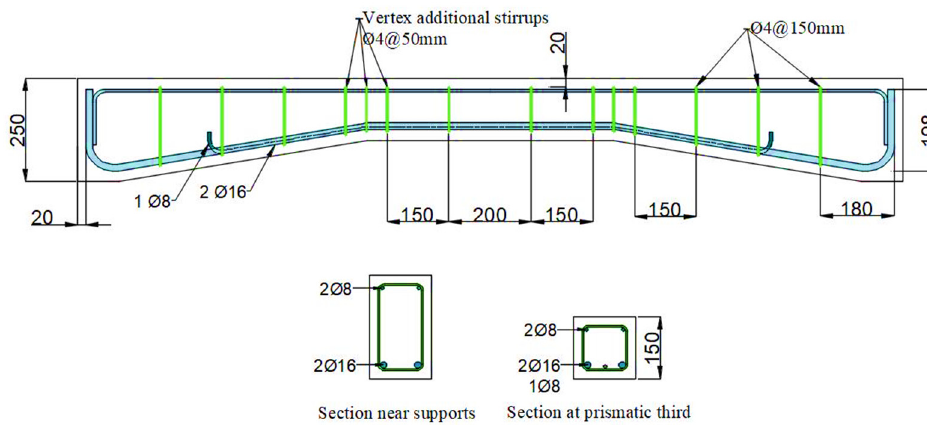
Figure 3. Rebar details for the used haunched beams.